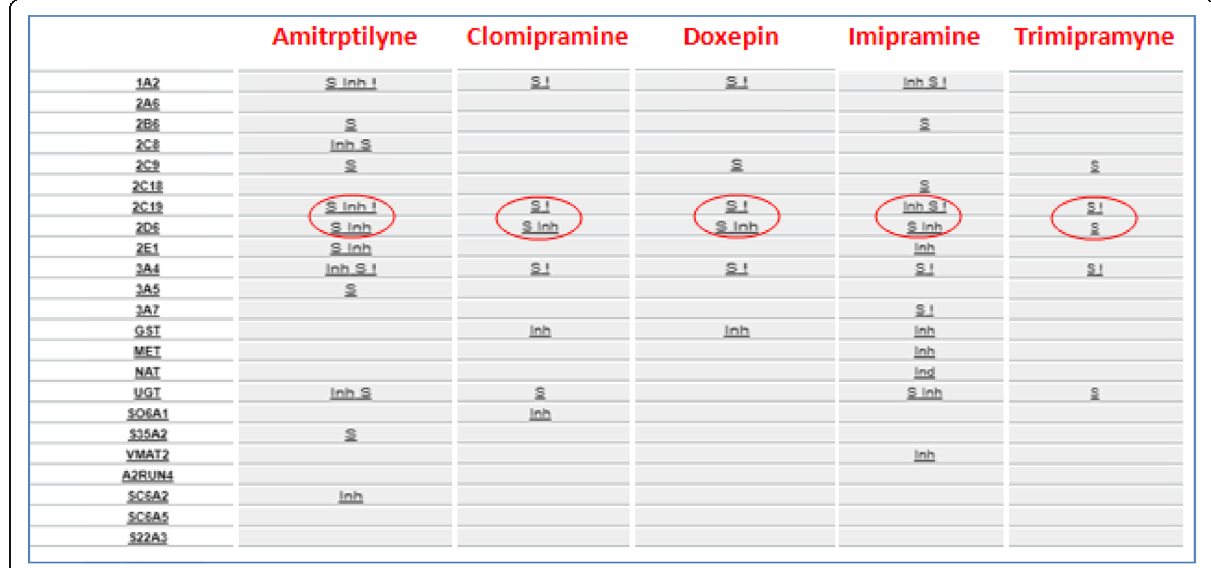
Fig. 7 Tertiary amines metabolic profile From left to right, in the first column there is the list of drug metabolizing enzymes, one for each row; in the second, third, fourth, fifth and sixth columns relationship between corresponding enzyme of the row and different Tricyclic: is indicated by the symbol ‘ S ’ for substrate, ‘ Inh ’ for inhibitor and ‘ Ind ’ for inducer. Enzymes CYP2C19 and 2D6 are rimmed to emphasize their importance in these tertiary amines ’ metabolic destiny. Related page at the website